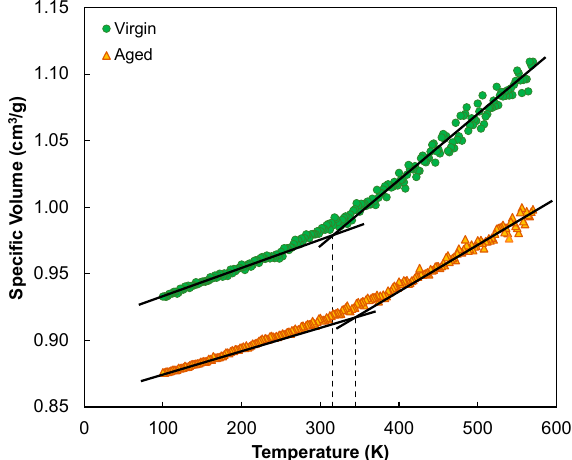
Figure 4. Determination of the glass transition temperatures.